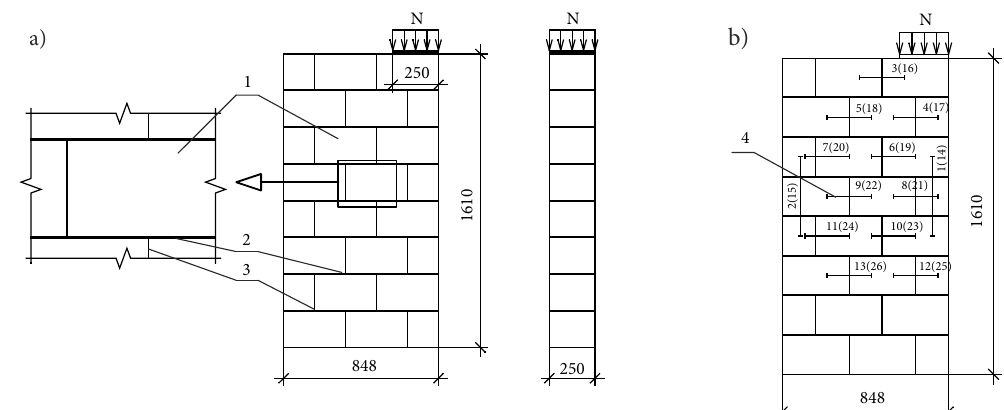
Figure 2. Test scheme of calcium silicate hollow blocks masonry wall compressed at the edge: a) fragment of wall; b) test scheme for wall fragment with measuring gauges: 1 – calcium silicate block; 2 – thin layered mortar bed joint; 3 – unfilled head joint